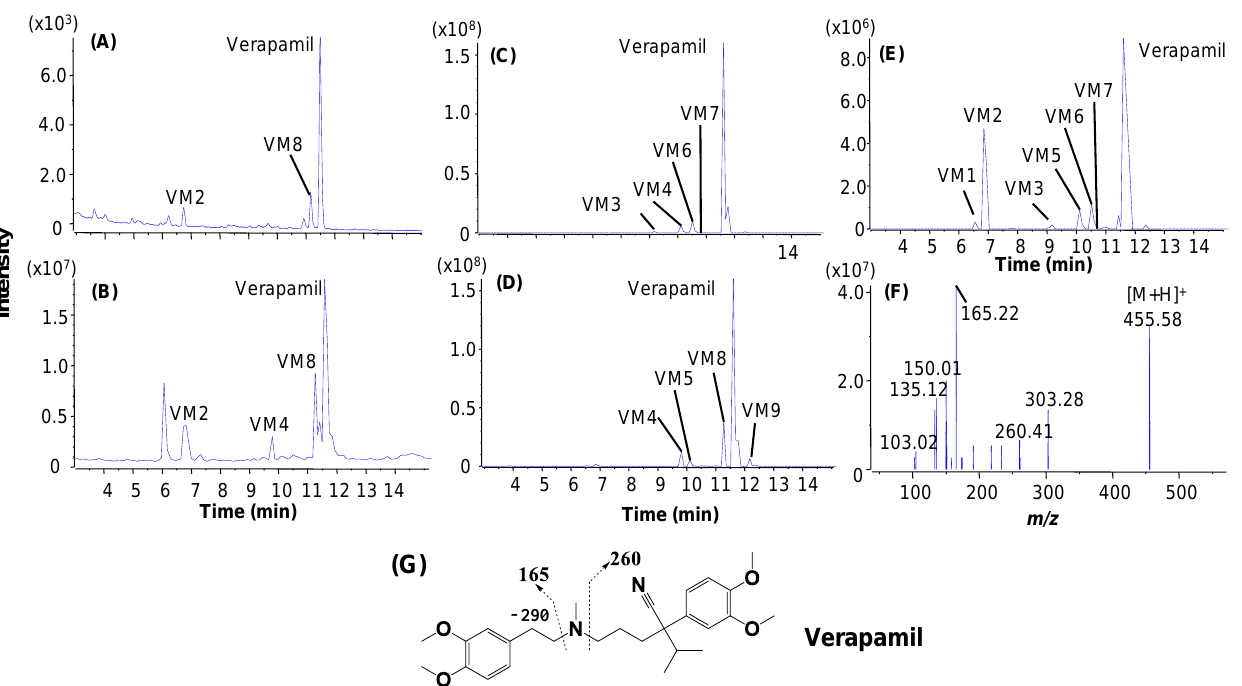
Figure 5. Metabolic soft-spot identification of dextromethorphan in HLM (3 µM, 4 min) by LC/UV/Qtrap. ( A ) LC/UV profile of a dextromethorphan control sample (0 min); ( B ) LC/UV profile of s dextromethorphan incubation sample (30 min); ( C ) LC/MS profile from the MIM-scanning analysis of the dextromethorphan incubation sample (30 min); ( D ) EIC of the dextromethorphan metabolites in the incubation (30 min); ( E ) MS/MS spectrum of DM2; ( F ) structure and fragmentation of DM2.